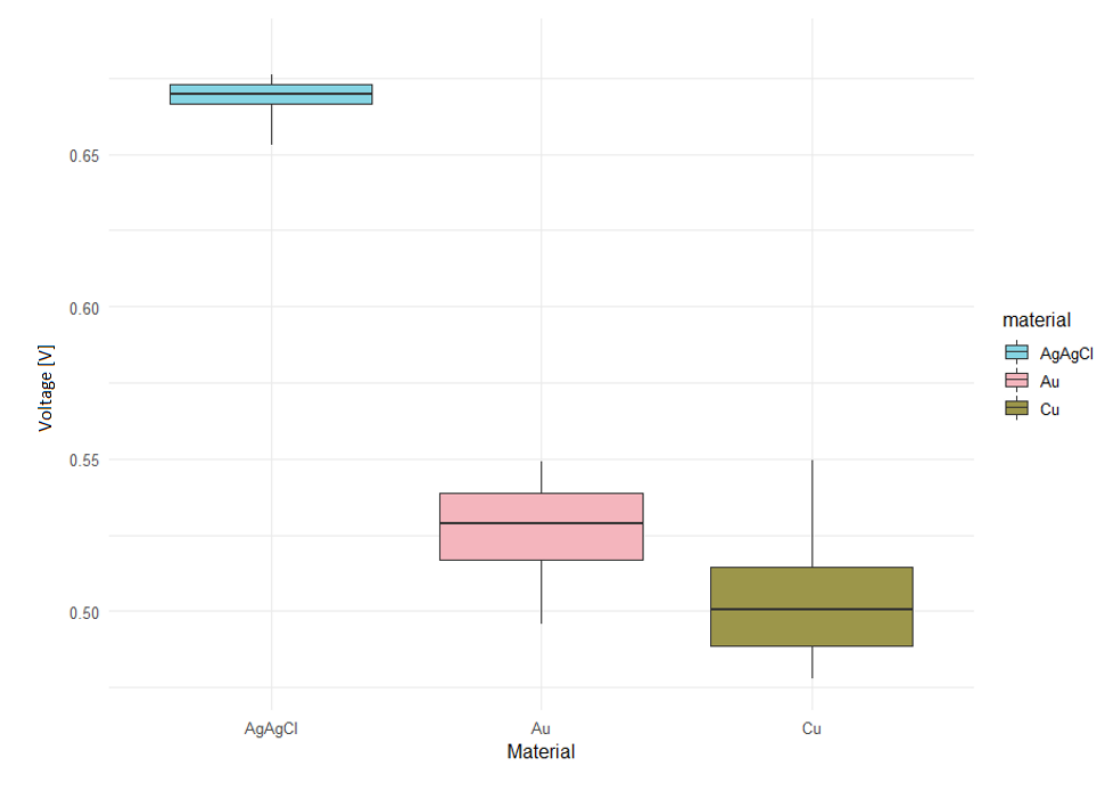
Figure 12. Voltage in concentration of 12 mM with